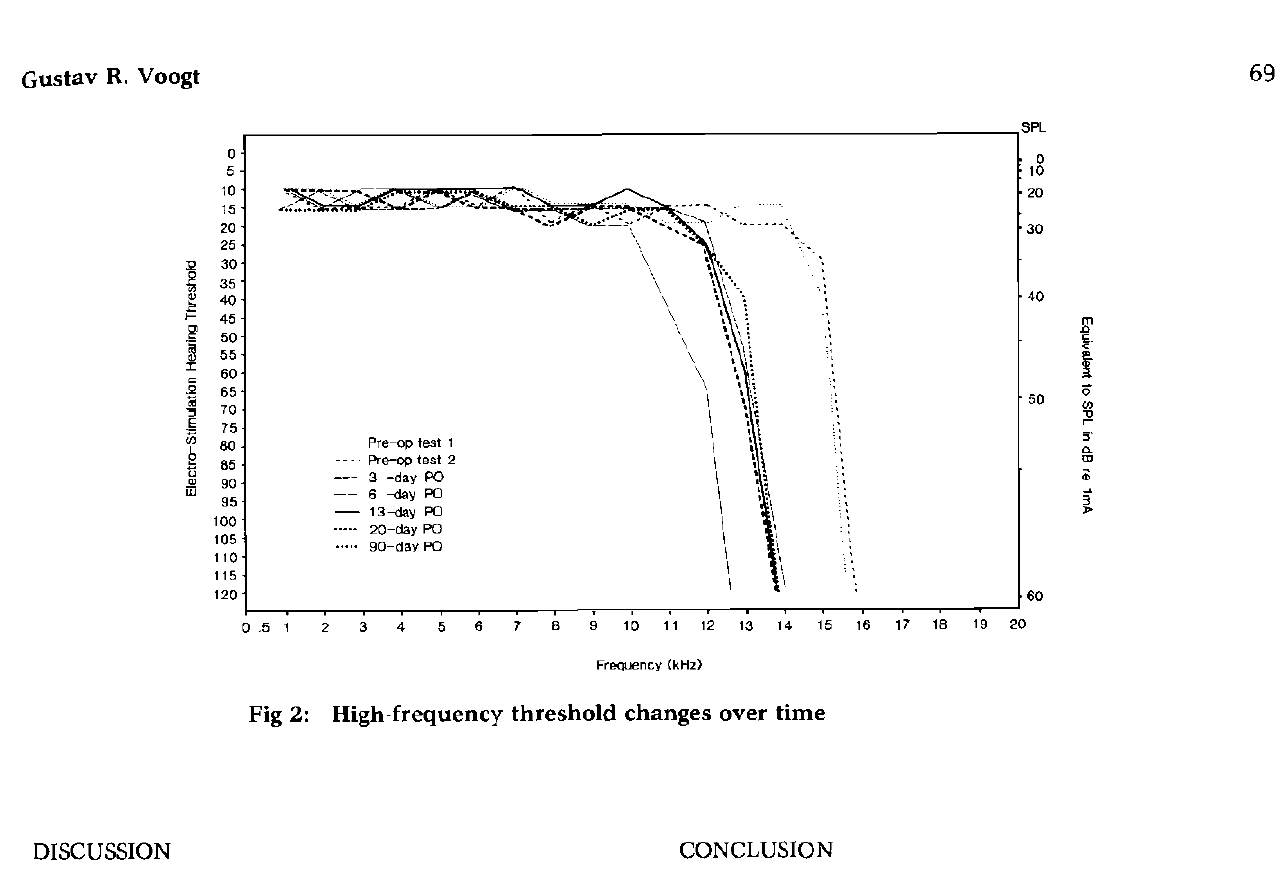
Fig 2: High-frequency threshold changes over